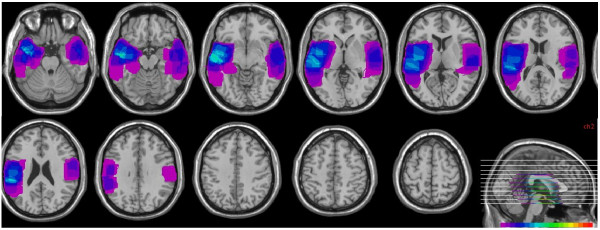
Composite images of damaged brain regions in the group of patients with temporal lobe cerebral infarction. Areas damaged in a subject are shown in purple; warmer shades denote the degree to which lesions involve the same structures in 2 or more individuals.